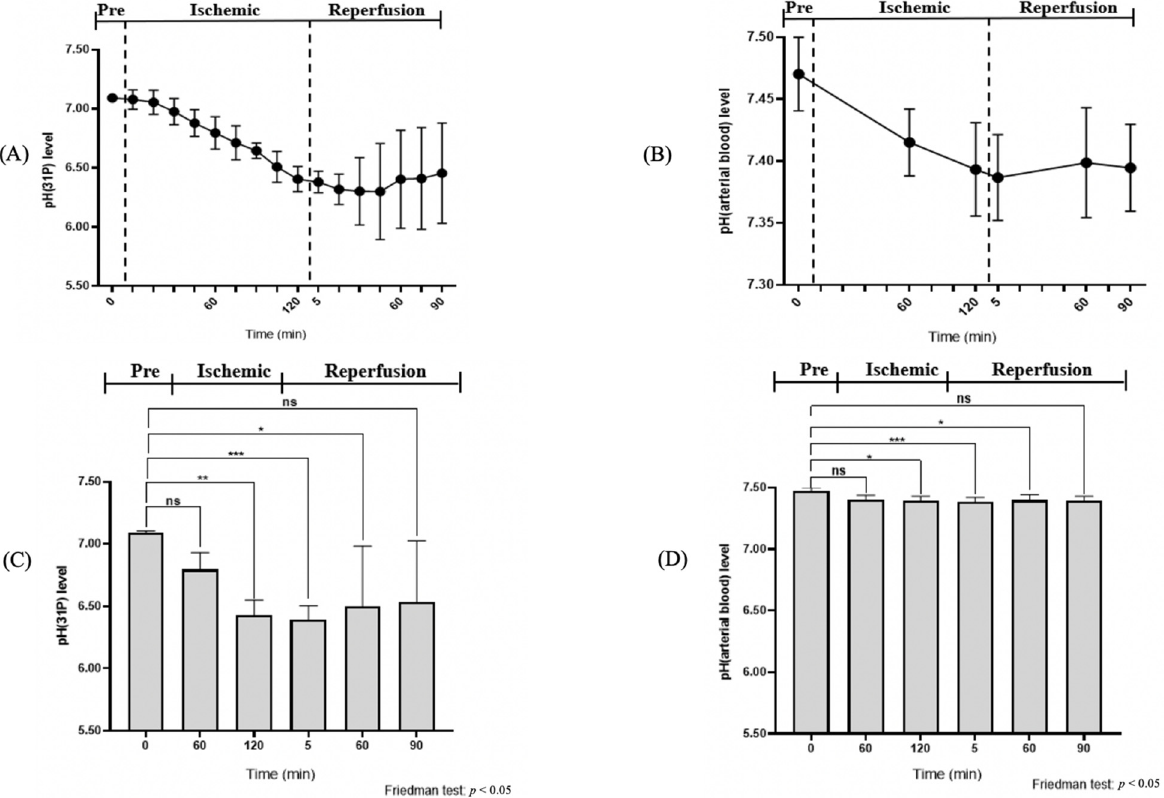
Figure 8. Dynamics in the concentration of intracellular pH and systemic pH during the ischemic and reperfusion states. ( A , B ) The change of the intracellular pH and arterial blood pH value during the experiment. ( C , D ) Comparison of the quantitative intracellular pH and arterial pH in pre-ischemia, ischemia, and reperfusion. ns (not significant); * (0.01 < p < 0.05), ** (0.001 < p < 0.005) and *** ( p < 0.001), based on the Friedman test.